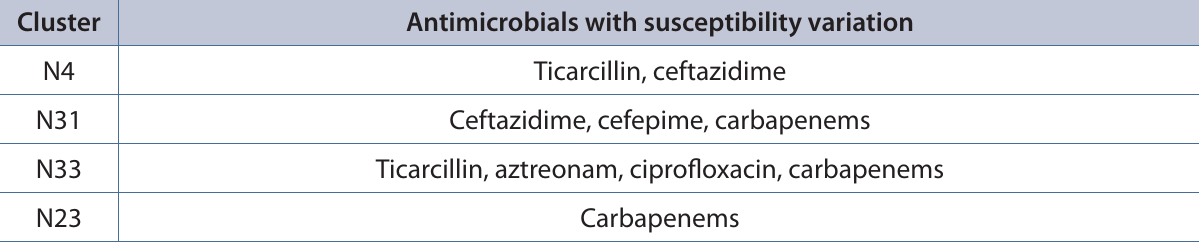
Table 1. Antimicrobial susceptibility variation within the same clone.